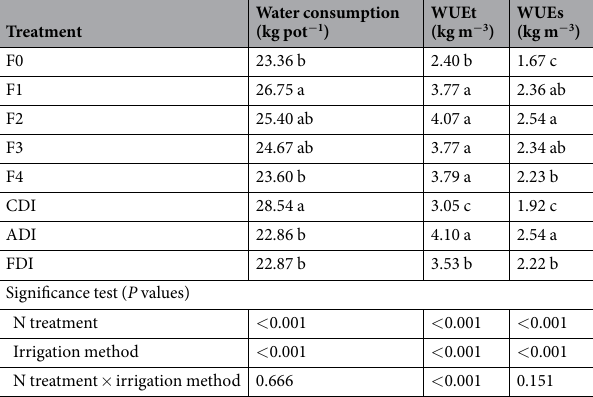
Table 2. Mean water use of sweet-waxy maize for different irrigation methods and N treatments. WUEt: water use efficiency on the basis of total dry mass, WUEs: water use efficiency on the basis of dry seed yield. Different small letters in the same column are significantly different for various N treatments or irrigation methods ( P < 0.05), and the same letters are not markedly different for various N treatments or irrigation methods ( P > 0.05).